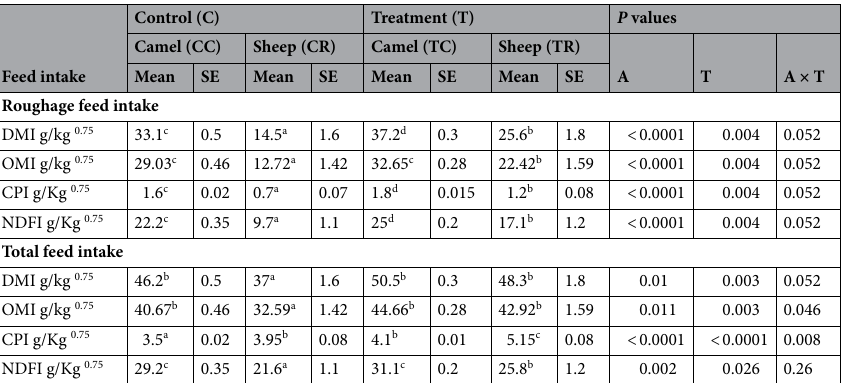
Table 2. Effect of YA supplementation on roughage and total feed intake expressed as g/Kg 0.75 of camel and sheep. A, animal species; T, feeding treatment; AXT, interaction between animal species and feeding treatment. DMI dry matter intake, OMI Organic matter intake, CPI crude protein intake, NDFI neutral detergent fiber intake, SE standard error, SEM standard error of the mean. a,b,c,d : Means in the same row with different superscripts differ significantly ( P <